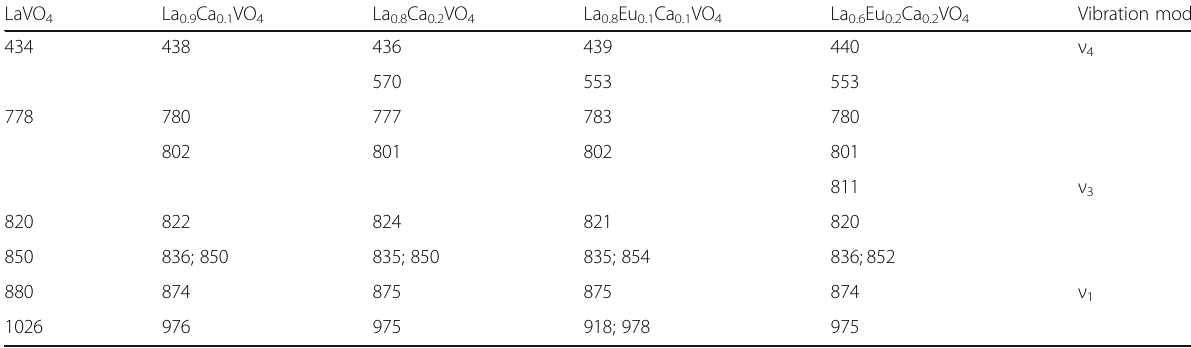
Table 2 IR peaks positions (in cm − 1 ) and their attributions to vibration modes in the VO 43 − vanadate groups LaVO